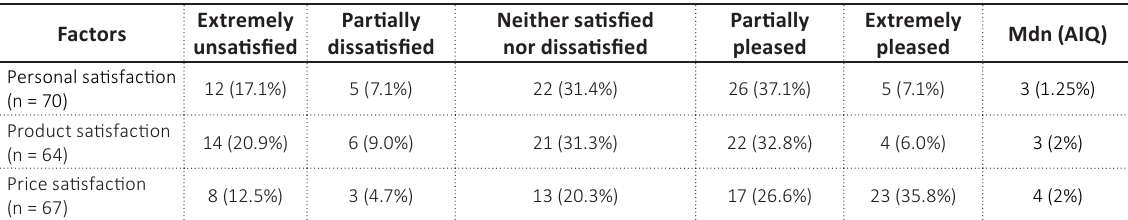
Table 3. Experience in the acquisition of counterfeit